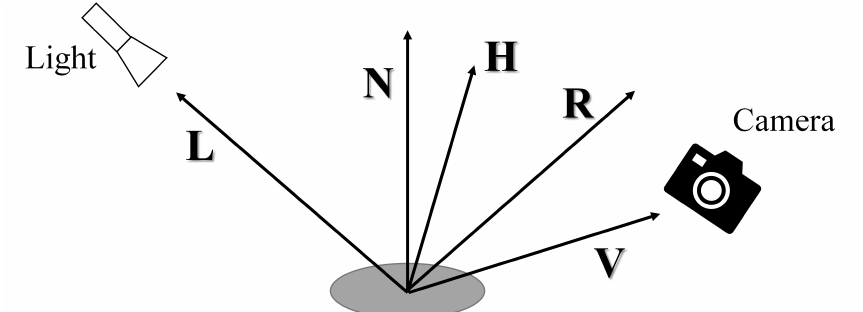
Figure 2. Diagram of the reflection